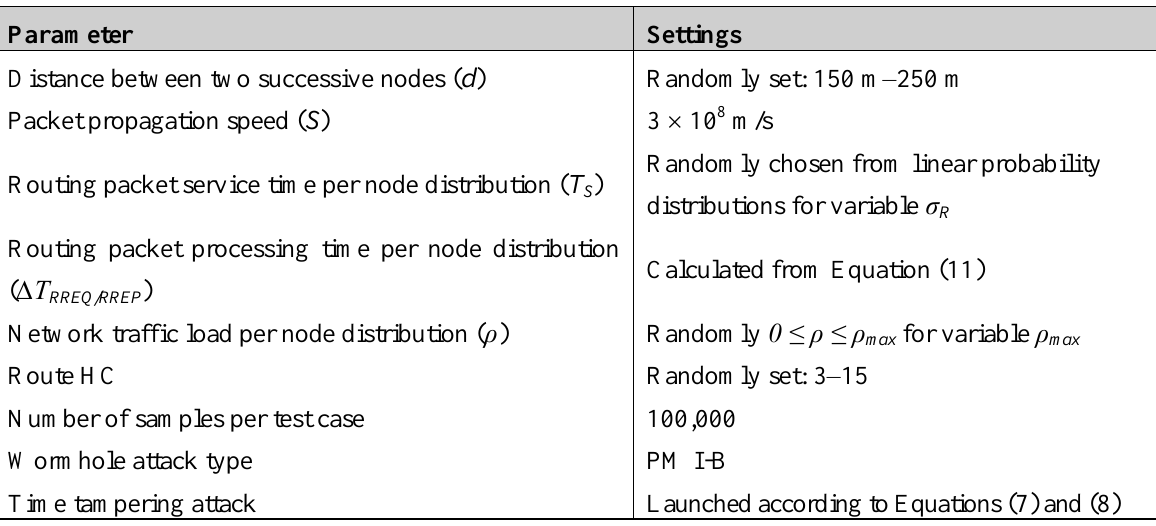
Table 1. Simulation parameter